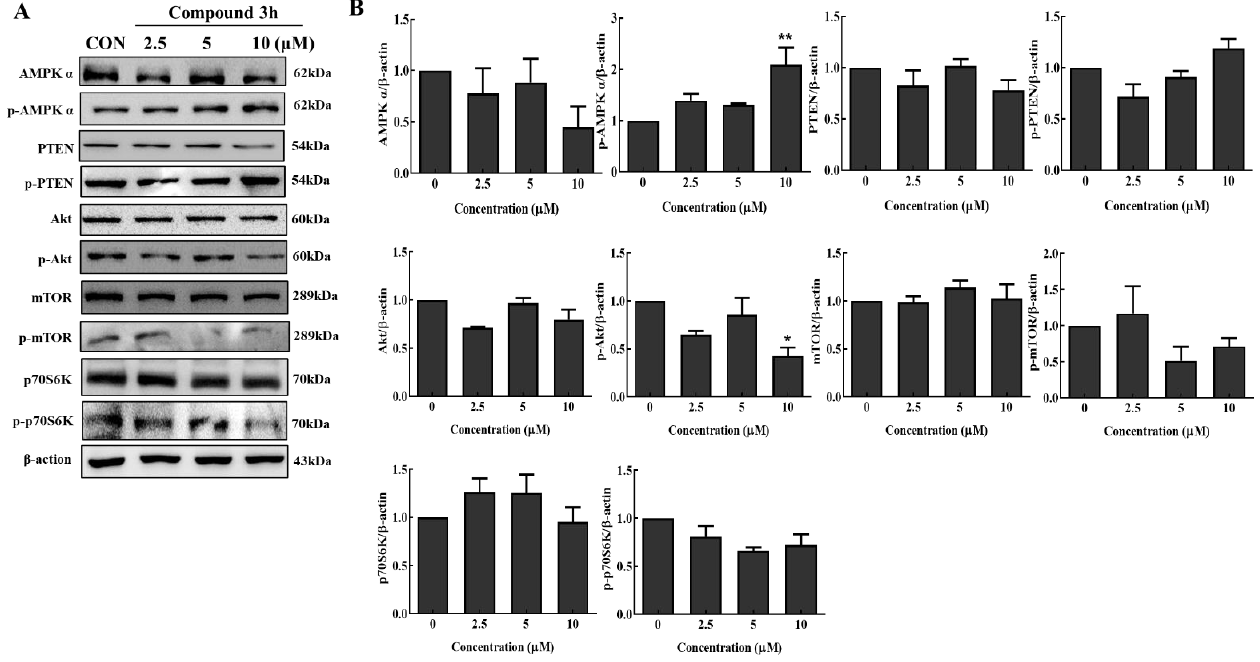
Figure 8. Changes in protein expression in signaling pathways in LNCaP cells after PKM2 inhibition by compound 3h . ( A ) Expression levels of proteins related to Akt/AMPK/mTOR signaling pathway. Compound 3h treatment suppressed the activation of Akt/mTOR. ( B ) Representative histogram showing the expression levels of proteins. The values represent the mean ± SD. * p < 0.05, and ** p < 0.01. The uncropped blots are shown Supplementary Material.